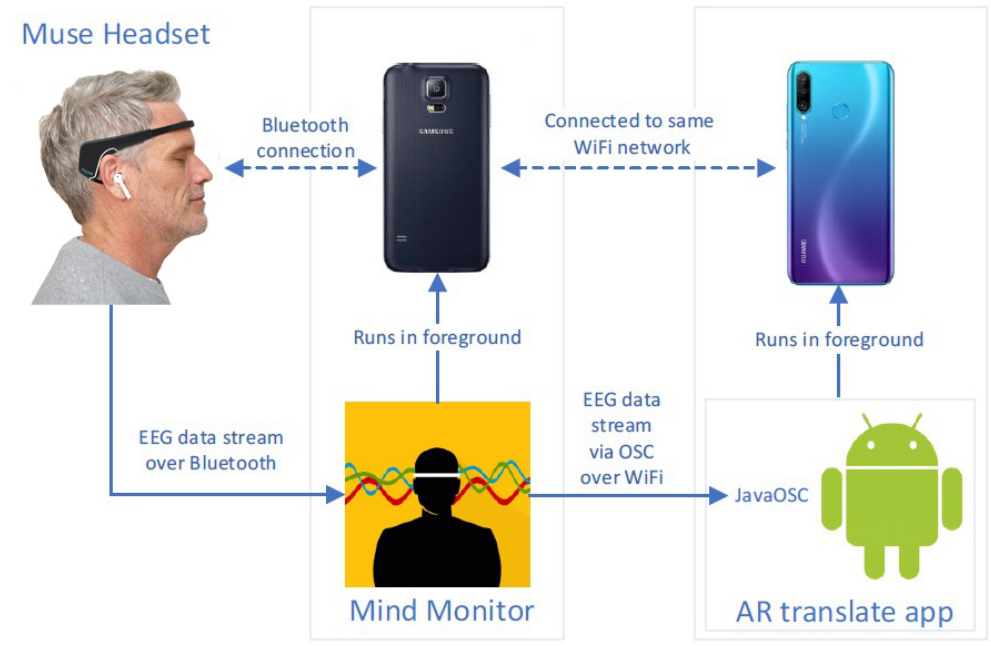
Figure 3. Schematic description of the data flow of the implemented system. The Muse 2 headset is connected to a fist smartphone via Bluetooth and sends the EEG data stream to the installed Mind Monitor app. A second smartphone that is connected to the same WiFi network is running the AR Translation application and receives the EEG data via OSC over WiFi from the first